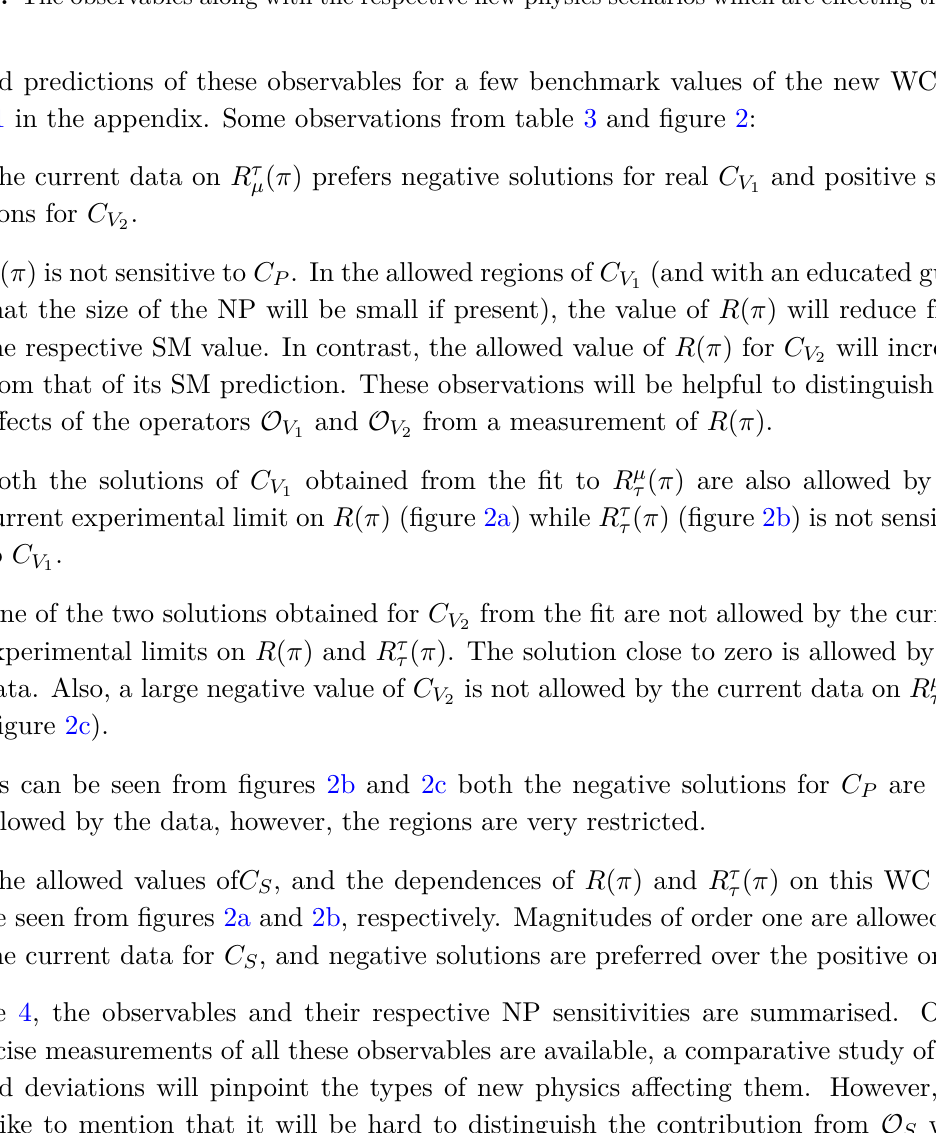
Table 4. The observables along with the respective new physics scenarios which are effecting them.